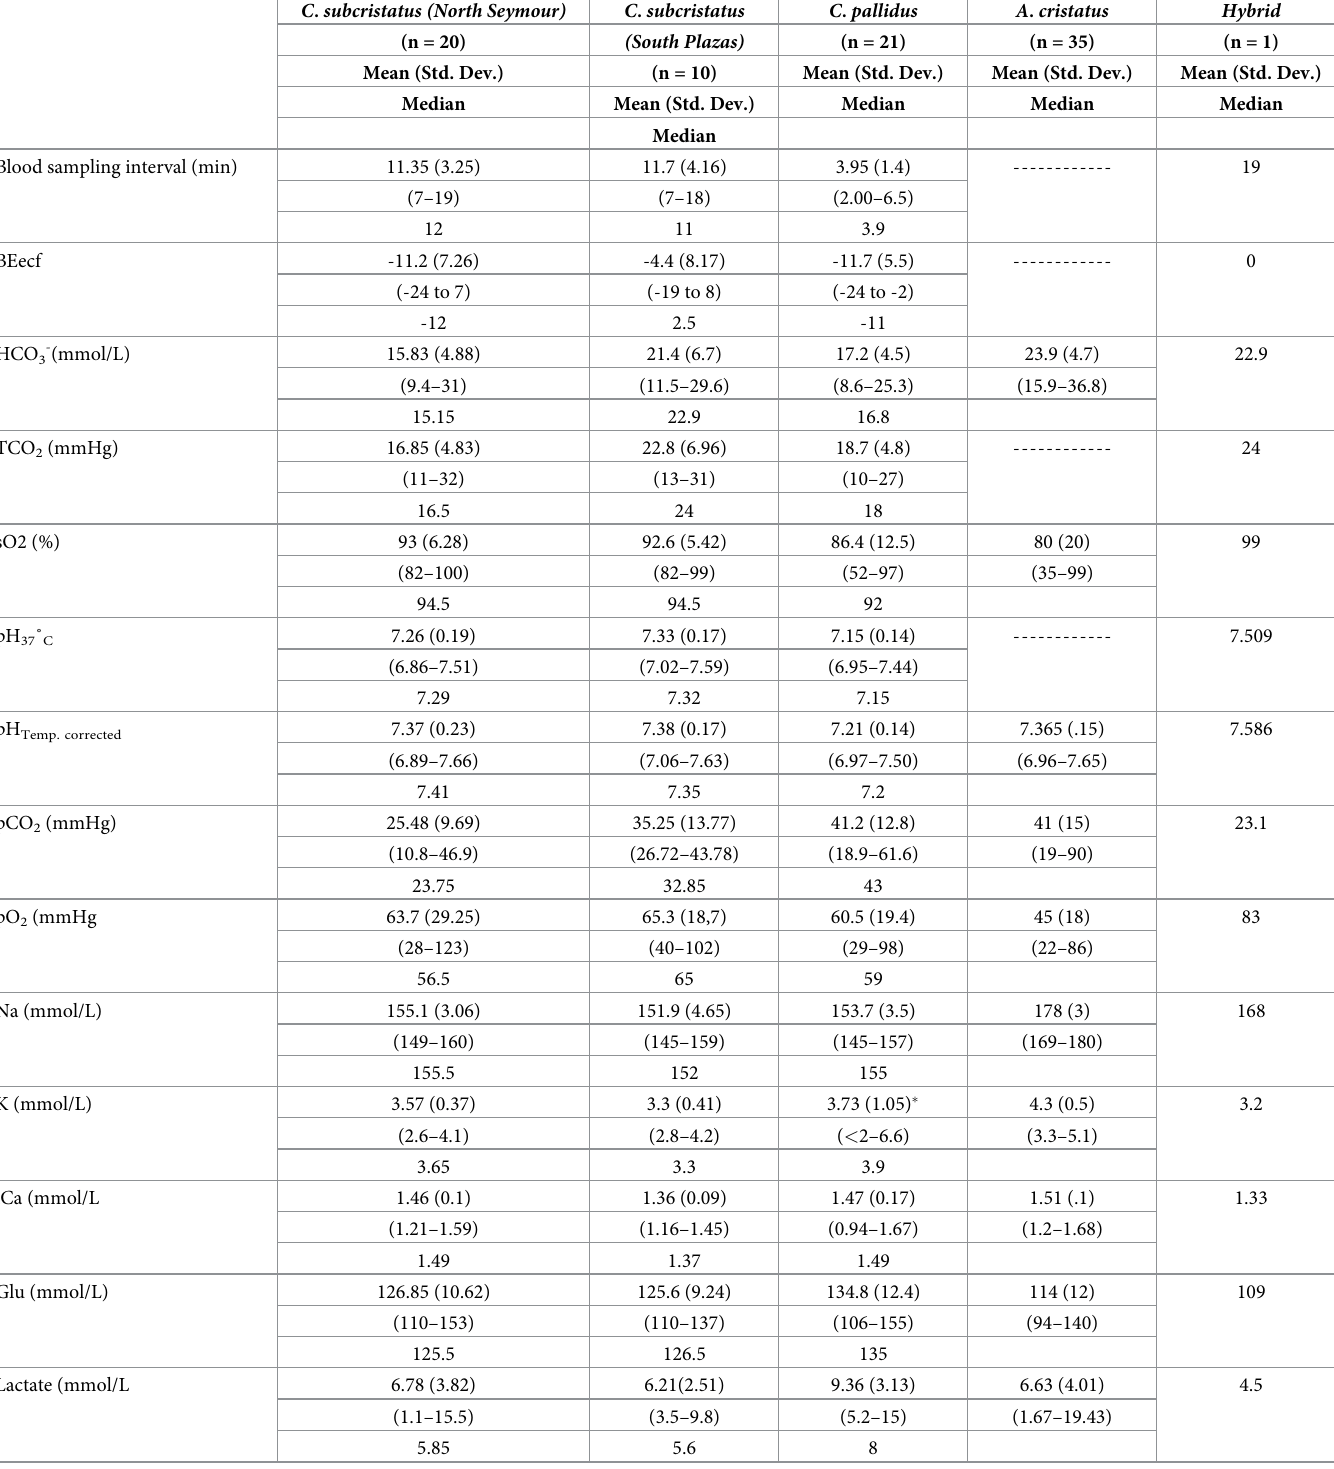
Table 2. Mean, standard deviation, and range for blood gas and blood biochemical values for wild Gala´pagos land iguanas with data included on marine iguanas